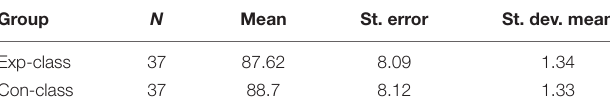
TABLE 1 | Group statistics (previous test).